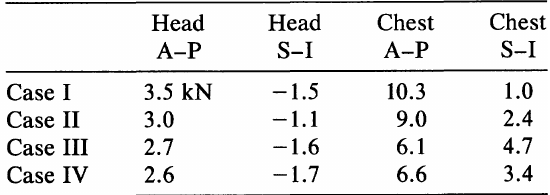
Table 1. Head and Upper Torso Contact Forces in A-P (Shear) and S-I (Axial)